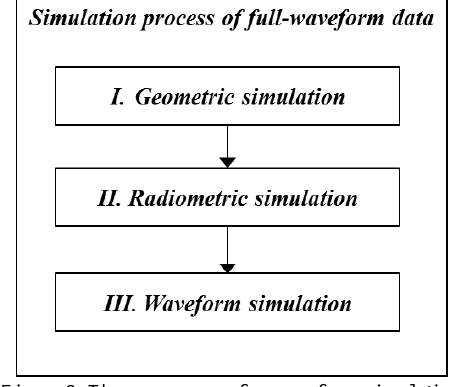
Figure 2. Three processes for waveform simulation